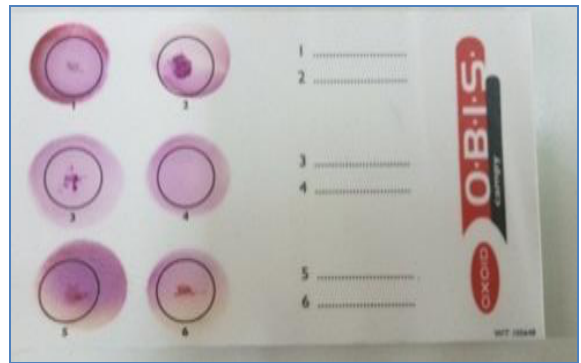
Figure, 3: Oxoid biochemical identification system campy (3, 4.5 No) colorless of colonies indicate the organism is Campylobacter spp. Table, 1: Biochemical test of bacterial isolates.